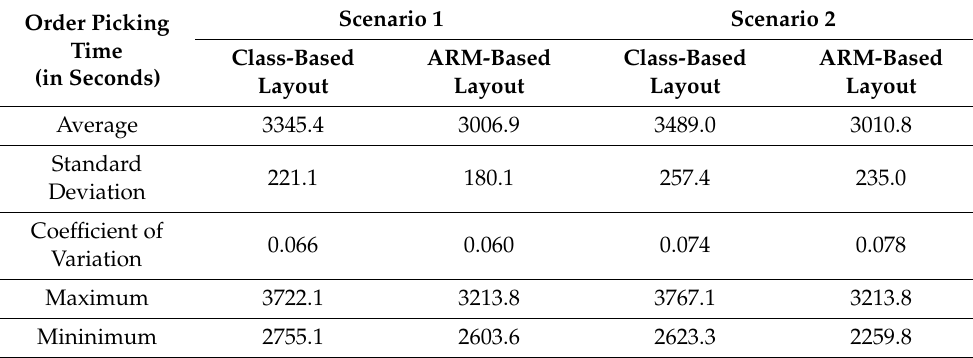
Figure 6. Comparison of class-based versus ARM-based layouts for Scenario 2. Table 4. Comparison of class-based versus ARM-based